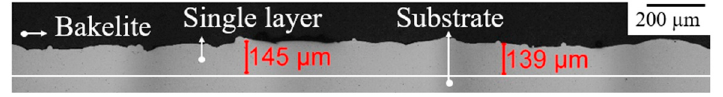
Figure 8. OM photograph of cross-section of a single layer.